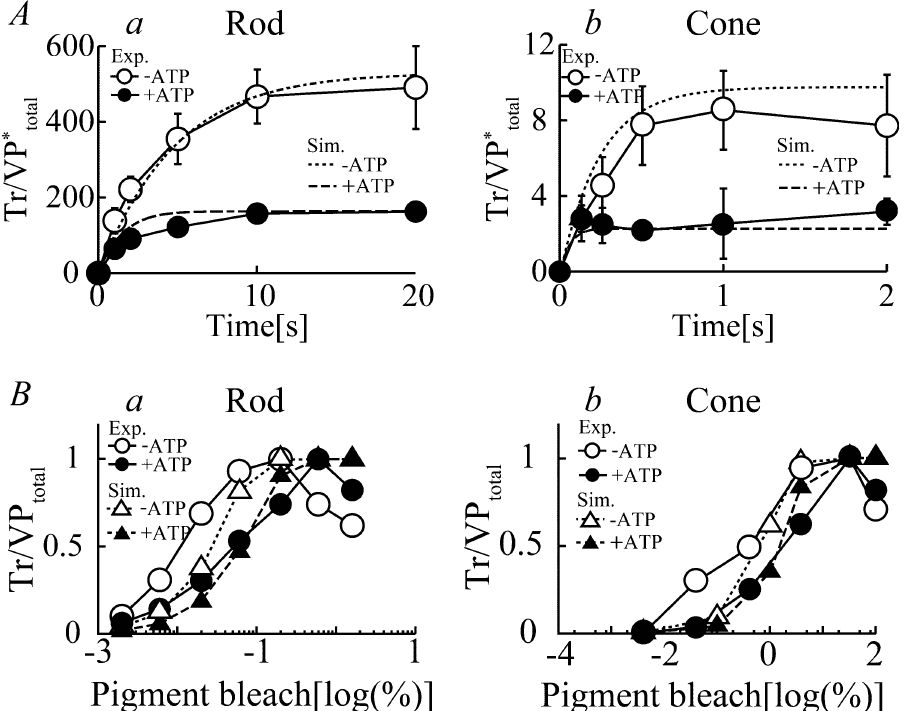
Figure 3. Transducin activation in rods and cones. ( A ) The time courses for Tr activation (the number of GTPγS molecule, a nonhydrolyzable GTP analog, incorporated per VP*) in the membrane preparations of purified carp rods and cones in response to light stimulation (0.0085% for rods (a, circle) and 0.25% for cones (b, circle)) in the presence (filled symbols) and absence (open symbols) of ATP (1 mM) as determined by biochemical experiments 18 . Corresponding simulation results (dotted lines (−ATP) and dashed lines (+ ATP) in a and b were superimposed onto the experimental results. ( B ) Light-induced GTPγS binding as a function of flash intensity in rods (a, circle, after 40 s stimulation) and cones (b, circle, after 20 s stimulation) in the presence (filled symbols) and absence (open symbols) of ATP (0.1 mM) normalized to maximum values. Simulated results for rods (a, triangle) and cones (b, triangle) reproduced under corresponding experimental conditions in the presence (filled symbols) and absence (open symbols) of ATP are also shown in the figure. Values for the rate constants for VP phosphorylation, kRK1–kRK6 and kiRK1–kiRK6, were set to 0 for simulation of experimental results obtained without